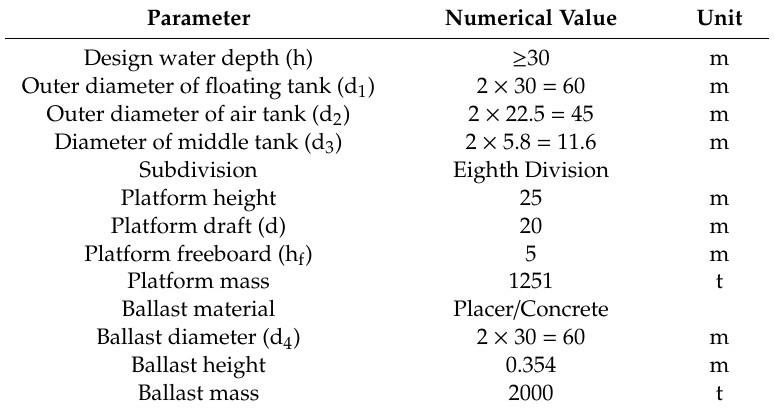
Figure 1. 3D model diagram of the zero-pressurized air-cushion-assisted barge platform. ( a ) Overall model diagram; ( b ) underwater structure model diagram. Table 1. Parameters of the zero-pressurized air-cushion-assisted barge